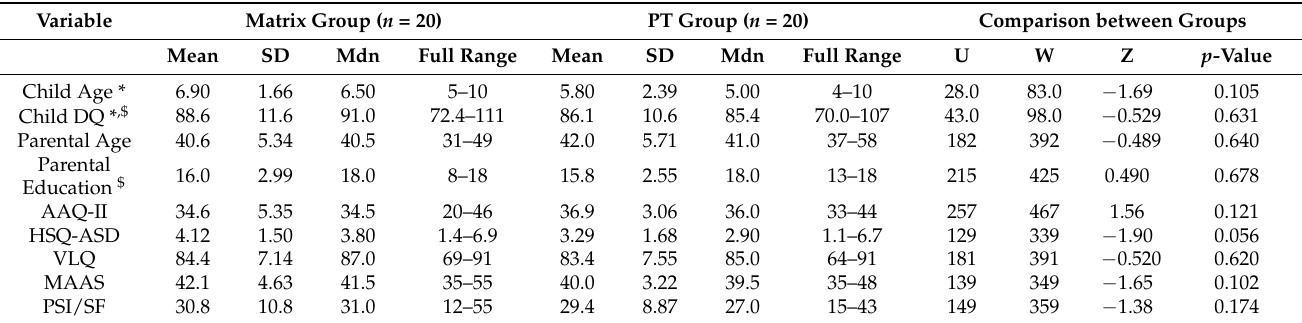
Table 1. Demographic characteristics and pre-intervention outcome variables of the